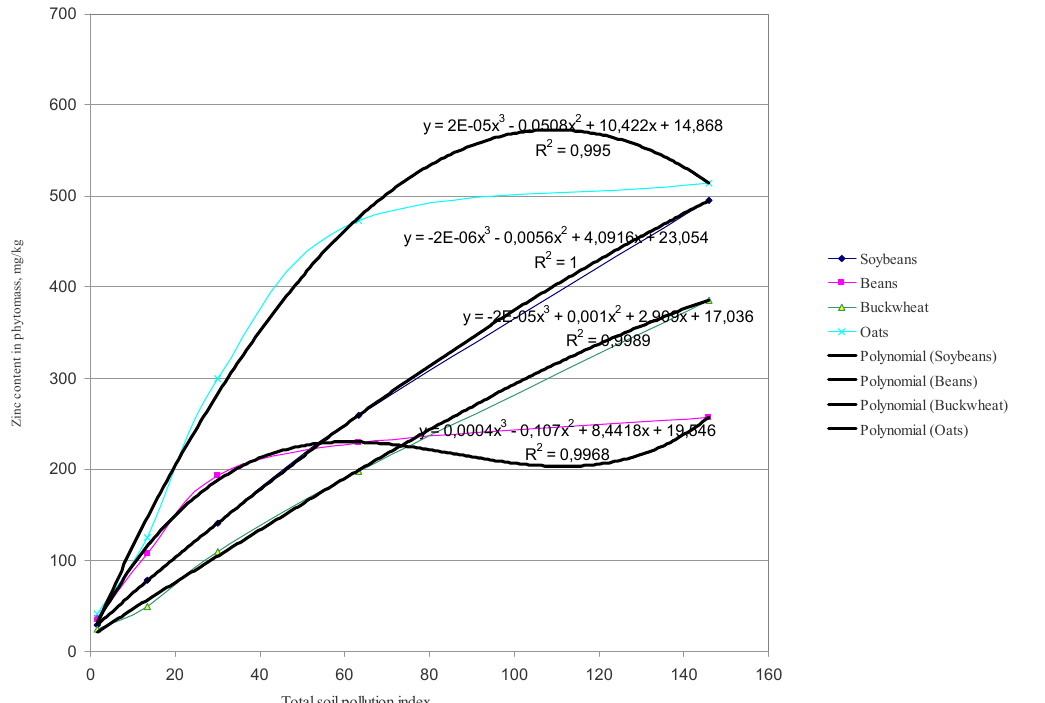
Figure 6. Dependence of zinc content in plant phytomass on the level of soil pollution.